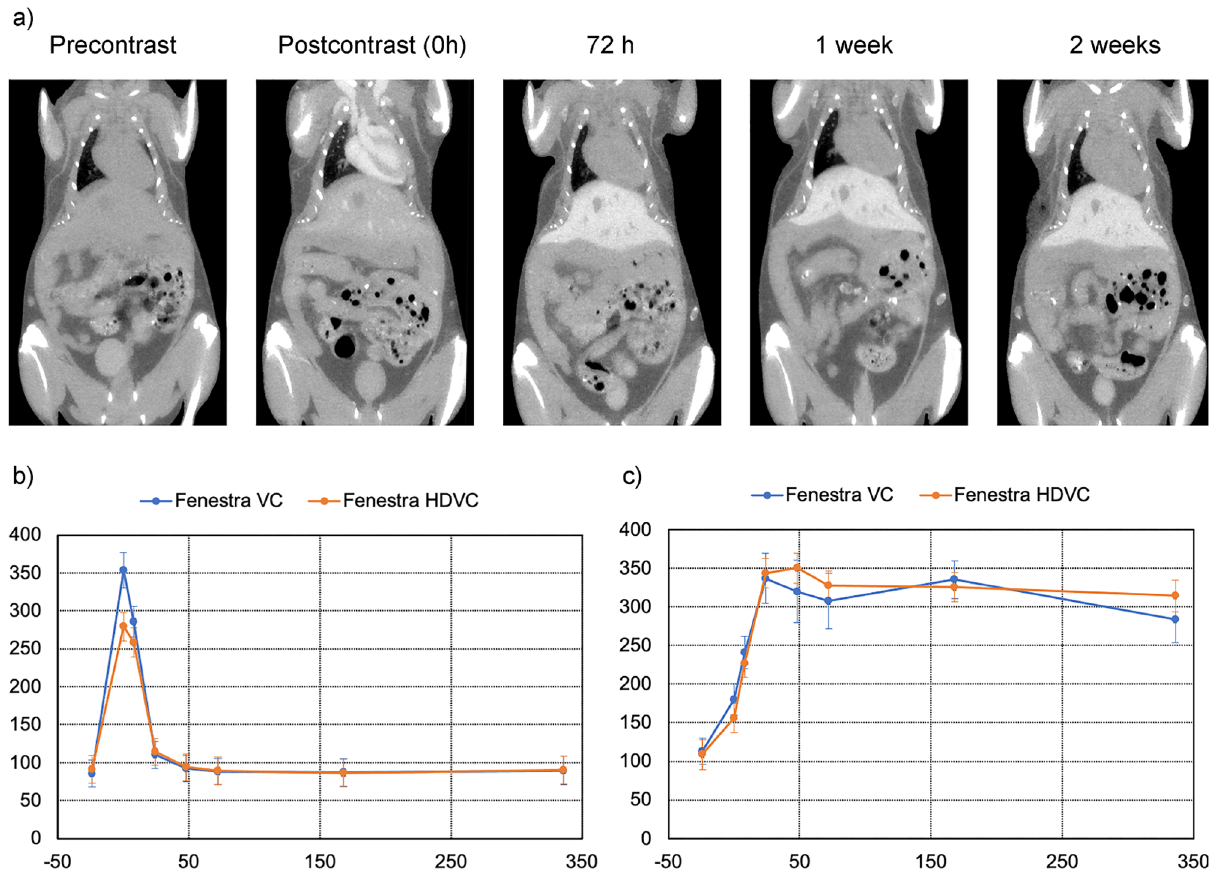
Figure 1. Time-course of contrast enhancement in a single mouse over a 2-week period. ( a ) Images obtained in vivo , with an isotropic voxel spacing of 0.1 mm. Average CT number in HU over the same 2-week period measured in the heart ( b ) and the liver ( c ) for Fenestra VC (blue) and Fenestra HDVC (orange). Data points are the mean and standard deviation of 5